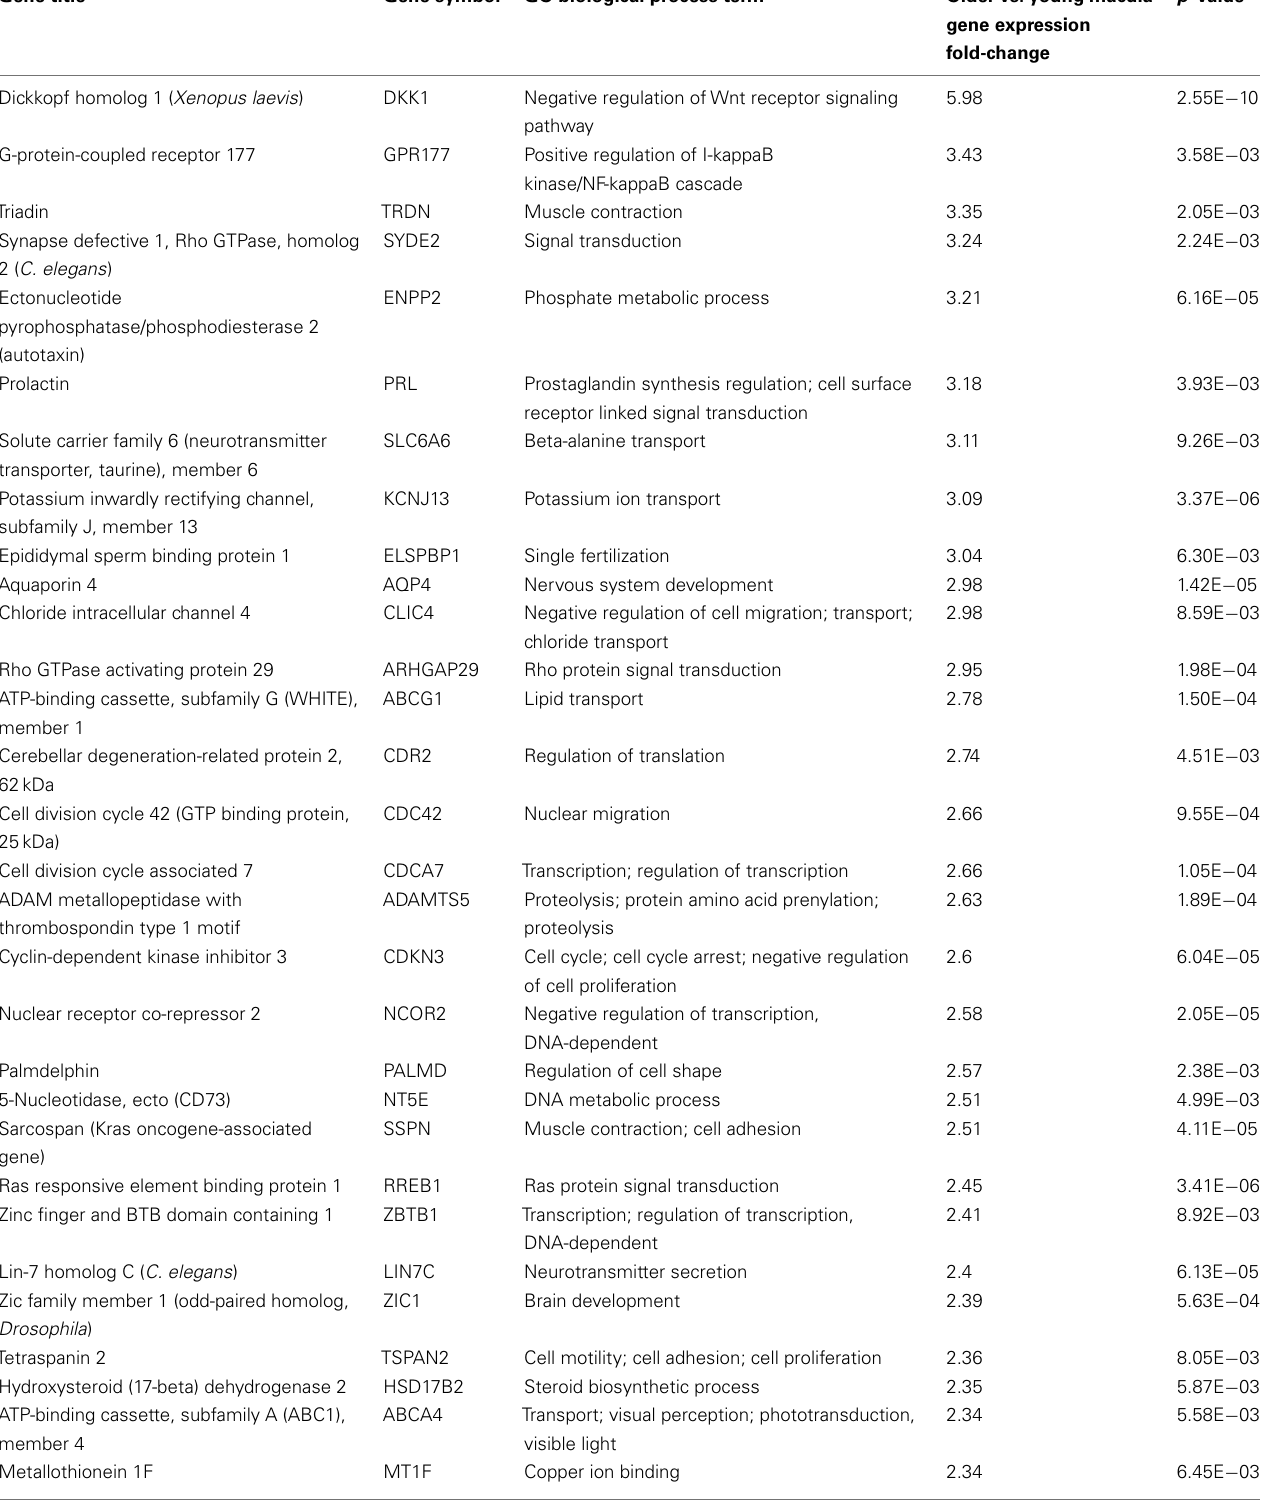
Table 6 | Genes highly expressed in old compared to young